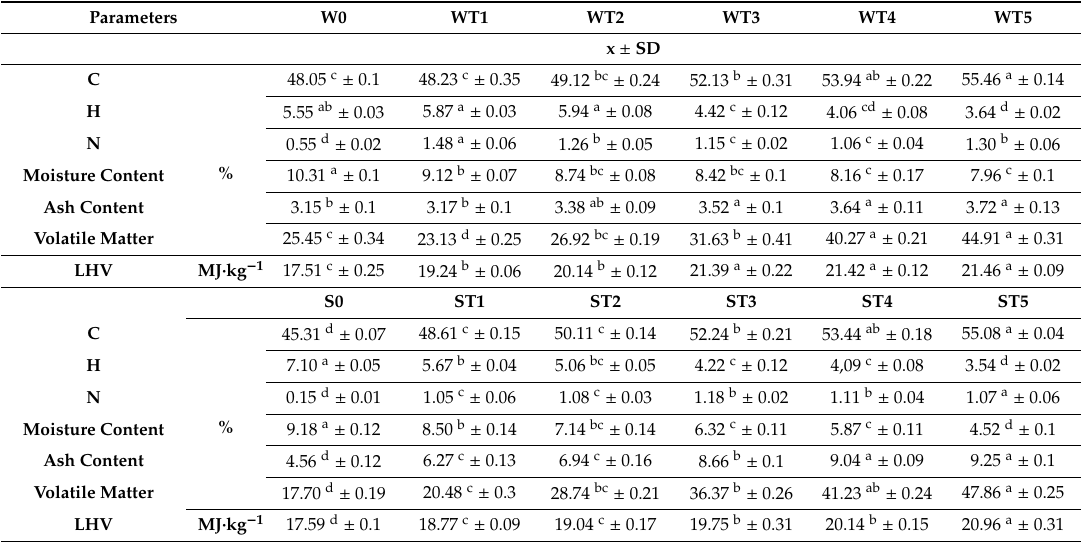
Table 1. The parameters identified for raw biomass and material torrefied for a duration of 60 min [32].